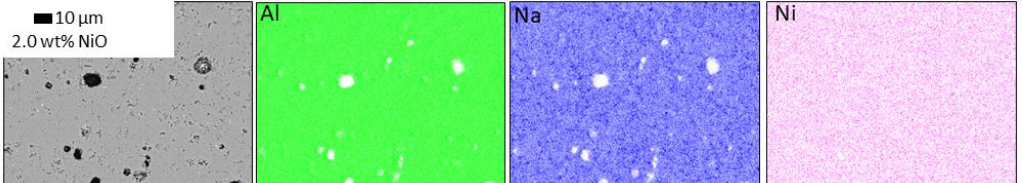
Figure 14. EDX mapping and backscattering SEM image of NiO-doped, polished Na- β″ -alumina samples (sintered at 1600 °C). Al is labeled green; Na is labeled blue; Ni is labeled pink.